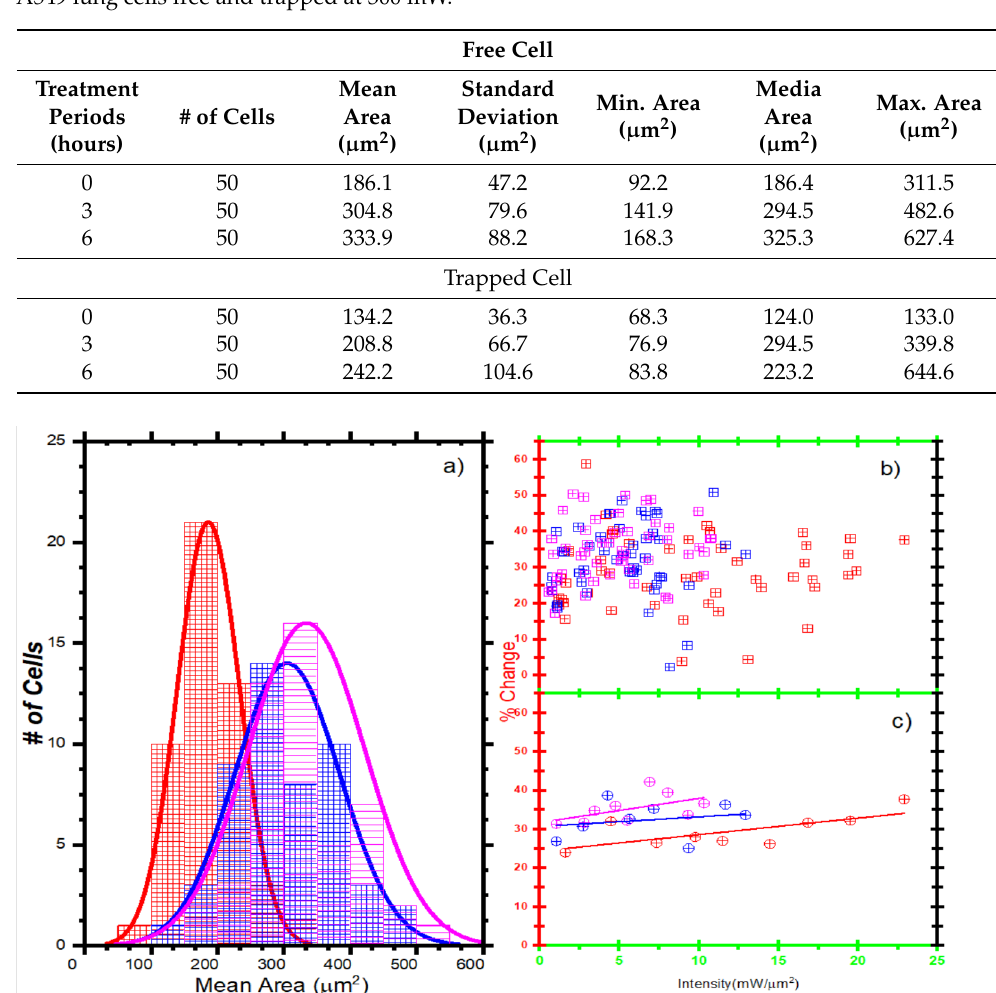
Figure 3. ( a ) The size distribution of the mean area of the untreated (red), 3 h treated (blue) and 6 h treated (magenta) cells; ( b ) the percent change of the free cells as a function of the intensity; ( c ) the reduced percent change of the cells as a function of the intensity for a free cell. In all ( a – c ), the traces of the behaviors were made using fourth-order polynomial